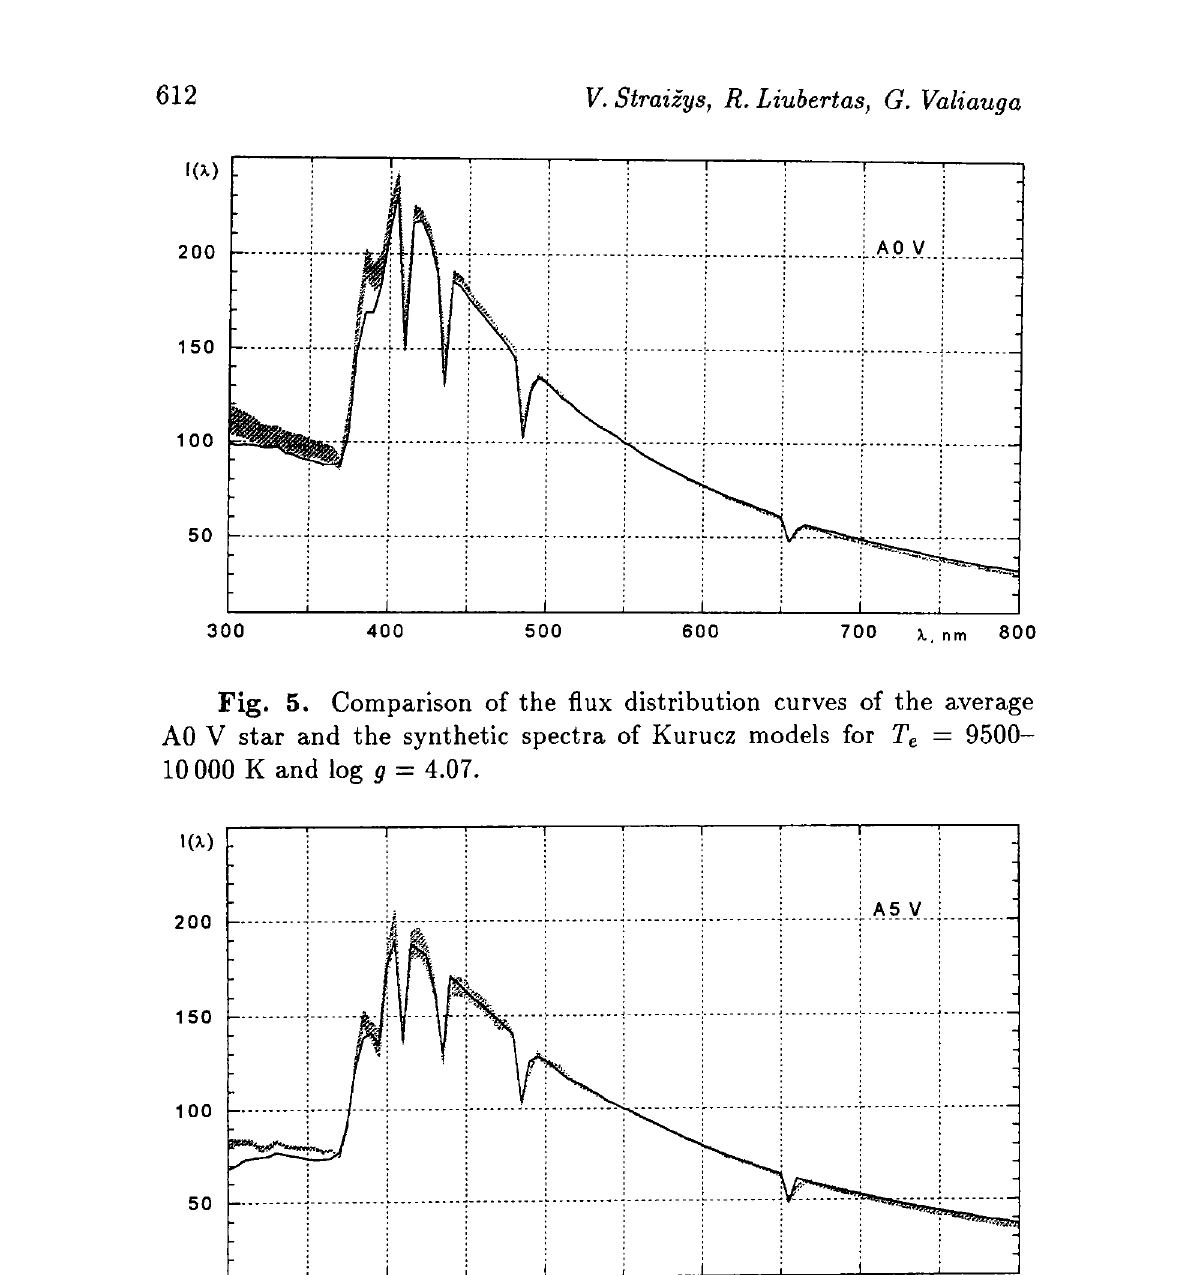
Fig. 6. Comparison of the flux distribution curves of the average A5 V star and the synthetic spectra of Kurucz models for T 8600 K and log g =